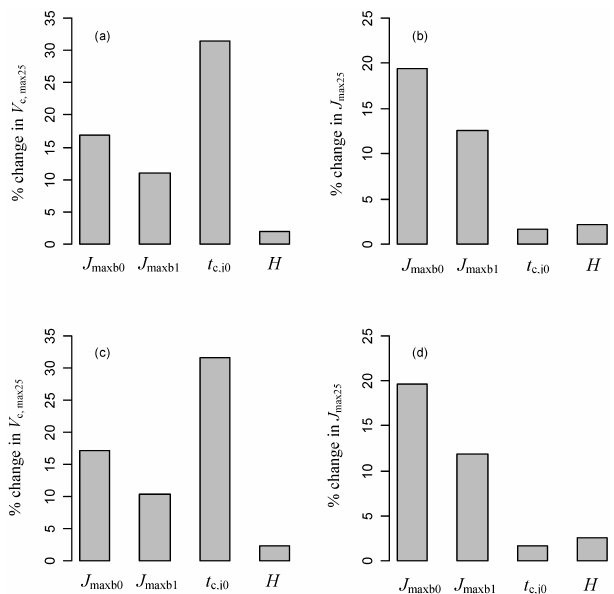
Figure 3. Sensitivities of V c , max25 (µmolCO 2 m − 2 s − 1 ) ( a : TRF1, c : TRF2) and J max25 (µmolelectronm − 2 s − 1 ) ( b : TRF1, d : TRF2) to changes in environmental variables including day length ( D ), daytime radiation ( R ), temperature ( T ), relative humidity (RH) and CO 2 concentration. Each environmental variable is varied one at a time by ± 15% around their mean values with day length = 14h, daytime radiation = 182Wm − 2 , temperature = 14 ◦ C, relative hu- midity = 0.6 (unitless) and CO 2 concentration = 393ppm. The model parameters ( J maxb0 , J maxb1 , t c ,j 0 , and H) are held fixed at their fitted values. V c,max25 and J max25 values are first obtained at changed environmental conditions and percentage changes in V c,max25 and J max25 are calculated relative to the baseline values of V c,max25 and J max25 under the mean climate conditions in the data. Positive values indicate that the increase in a specific environ- mental variable leads to larger values of V c,max25 and J max25, while negative values indicate that the increase in a specific environmental variable leads to smaller values of V c,max25 and J max25